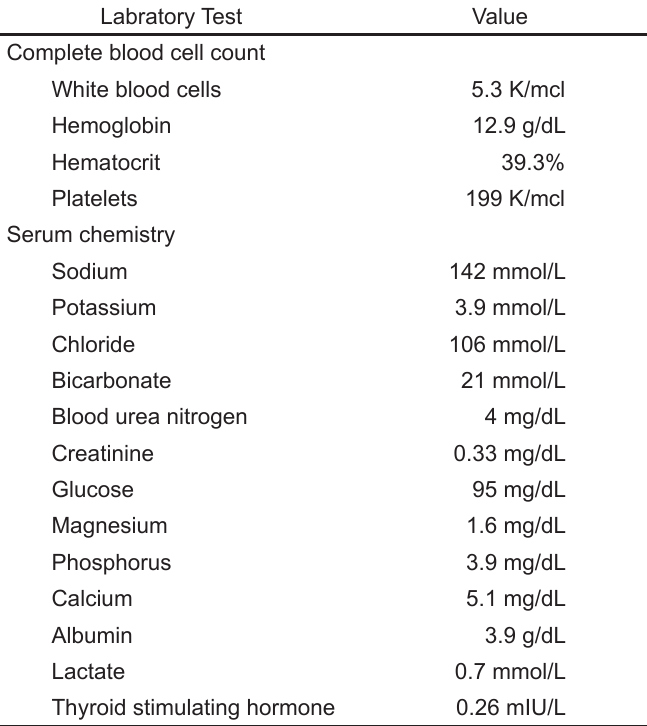
Table. Laboratory results for an eight-year-old boy with a new- onset seizure.